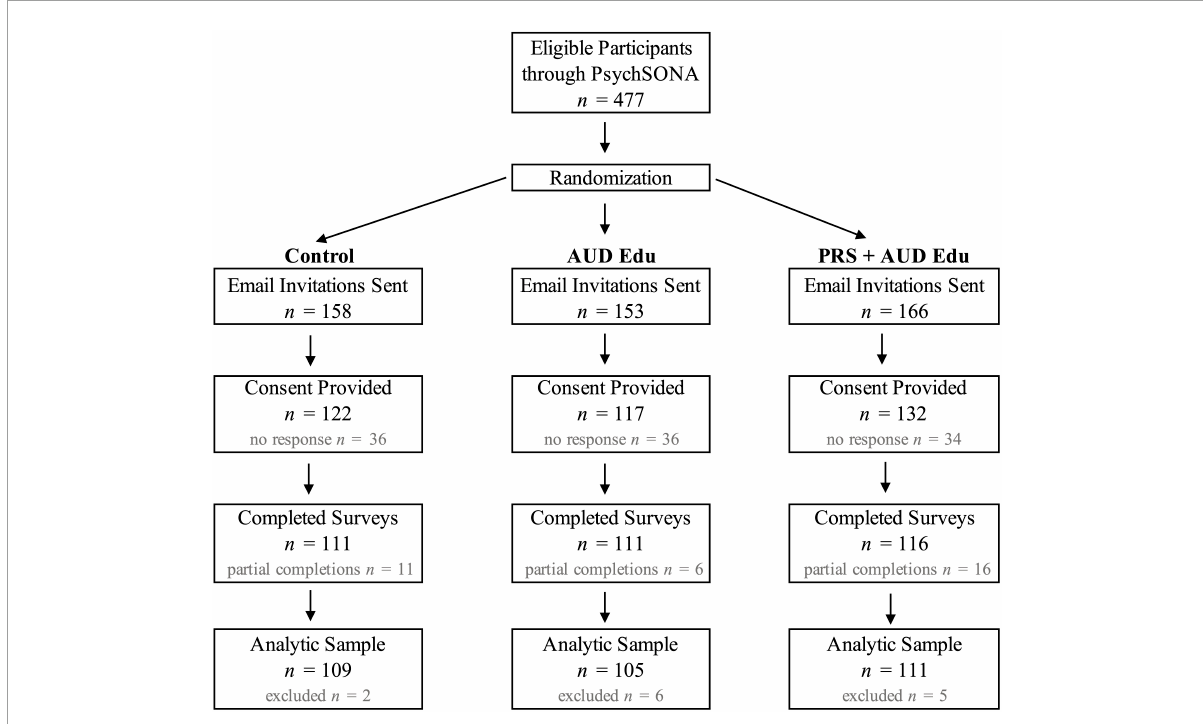
FIGURE1 Consort diagram illustrating recruitment details for the